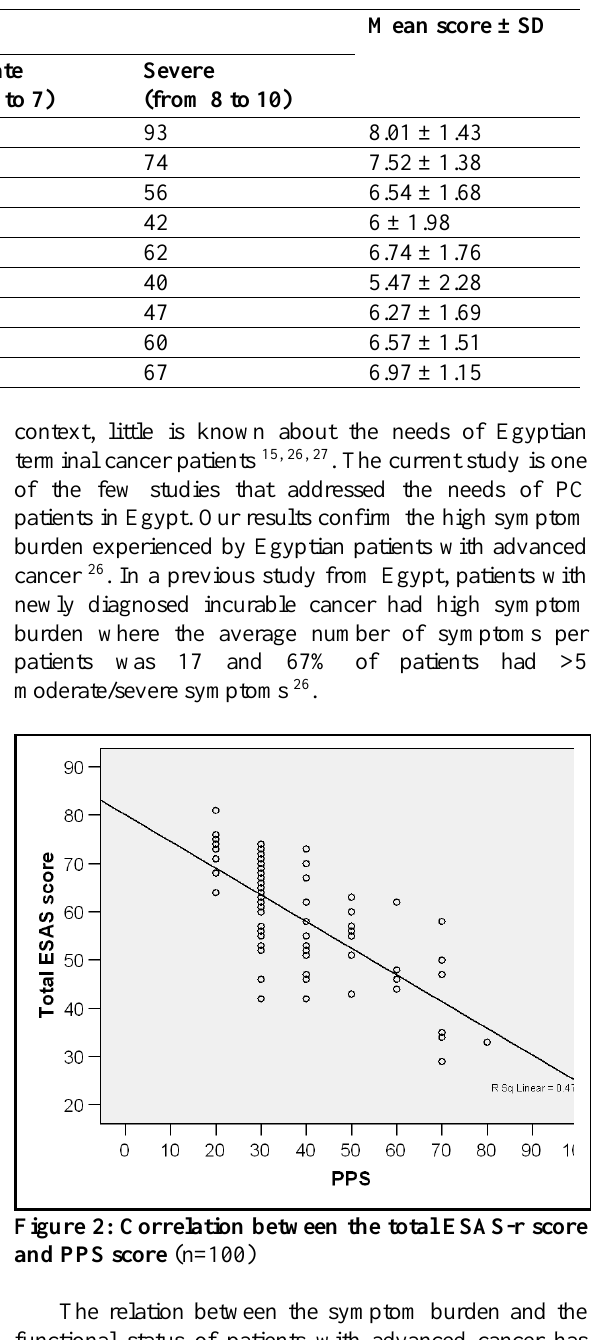
Table 2: ESAS items’ scores severity of study participants (n=100)